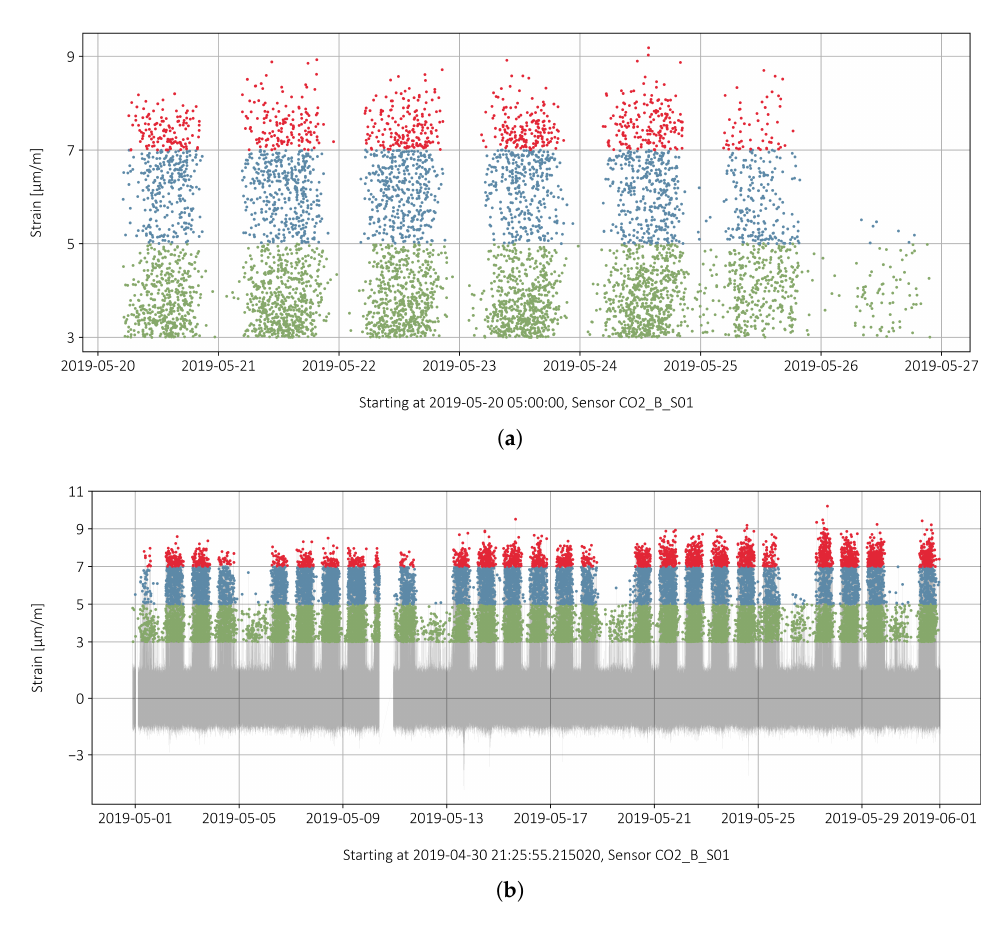
Figure 9. Strains and max. strains for different periods: ( a ) one week just peaks; and ( b ) one month with underlying normalized